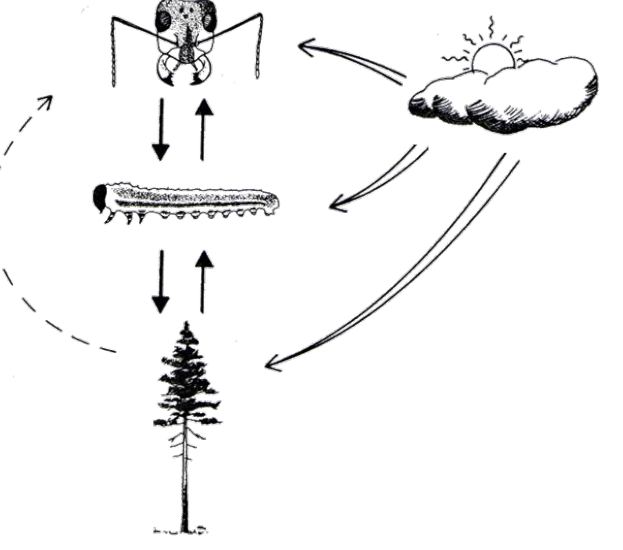
Figure 2. Not only is the forest insect pest affected by changes in the environment, e.g., the climate, but also their host plants and natural enemies. In order to predict the risk for more insect damage in the future we need to understand how bottom-up (through the host tree) and top-down (through the natural enemies) interactions are